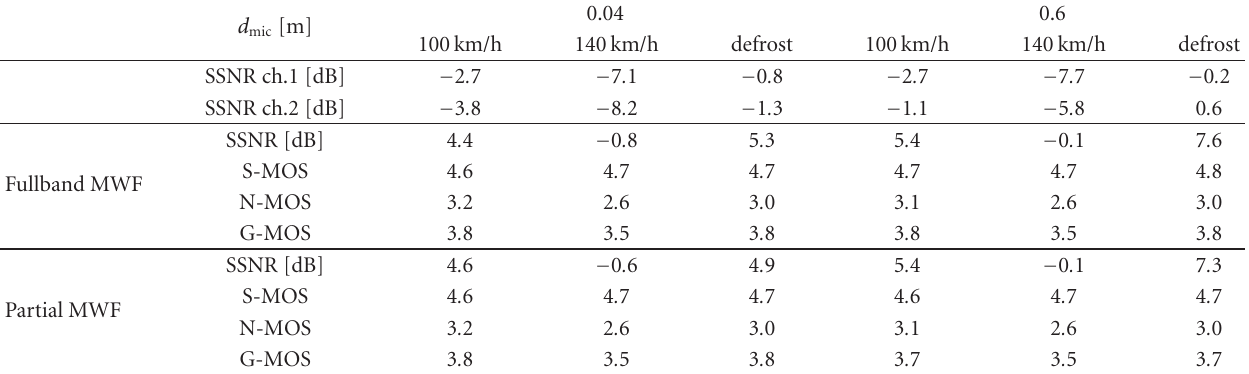
Table 1: Comparison of the fullband (according to (18)) and partial MWF (according to